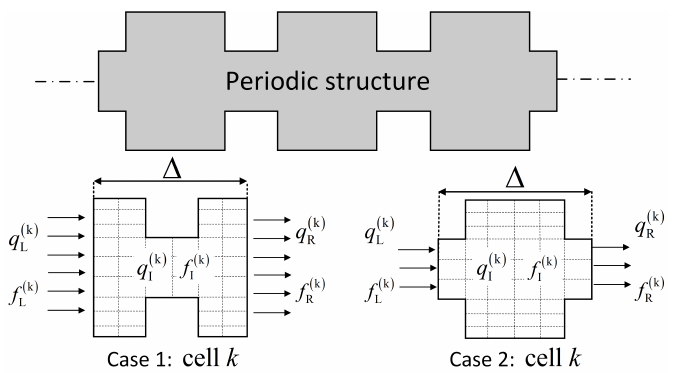
Figure 2. One-dimensional periodic structure. Cases 1 and 2 represent two arbitrary periodic